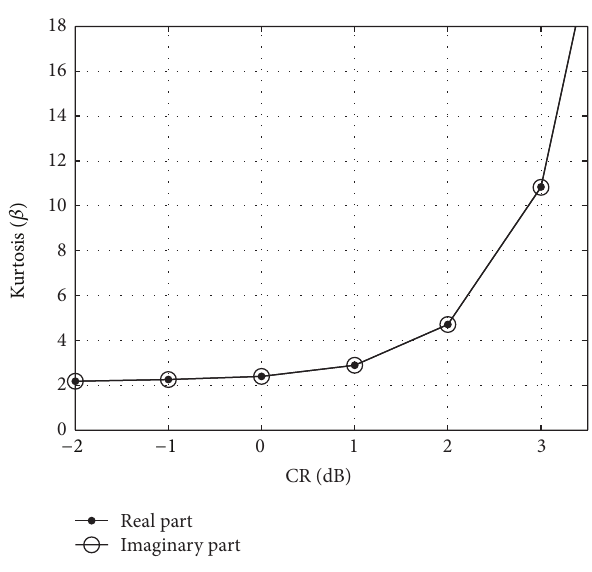
Figure 8: Kurtosis ( 𝛽 ) of the clipping noise as a function of the clipping ratio